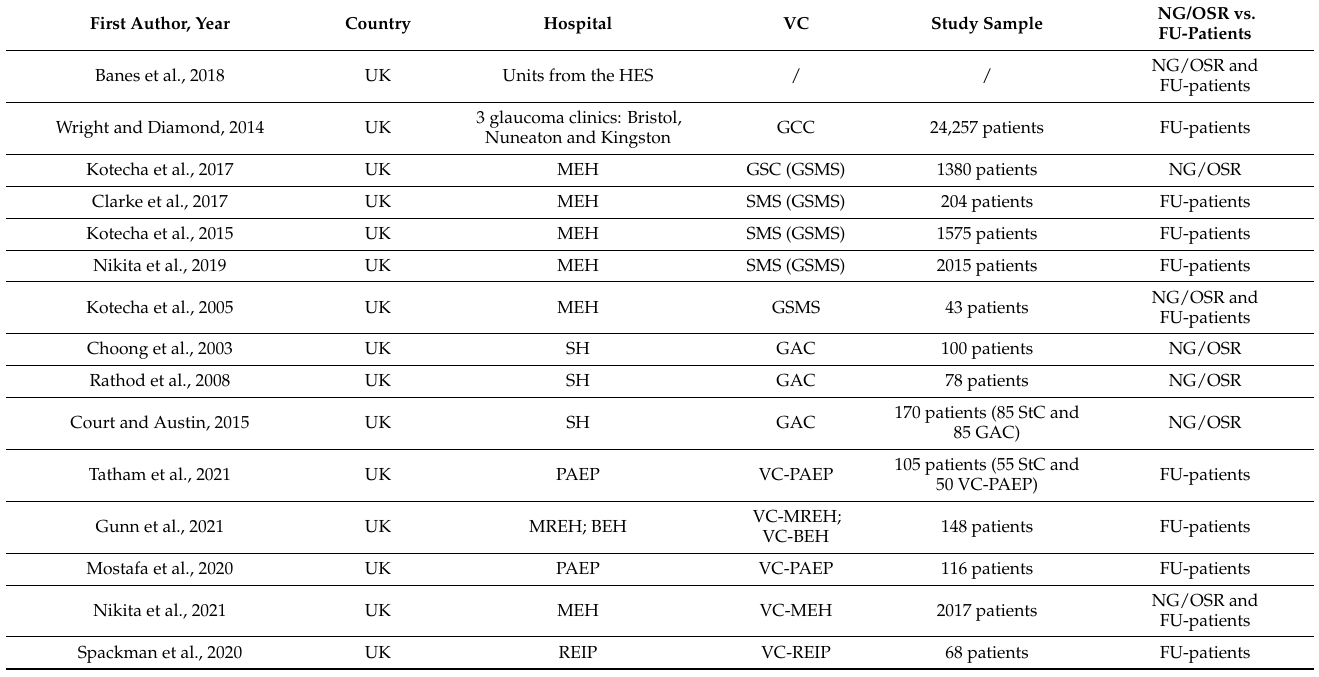
Figure 2. Study selection PRISMA flow chart on Virtual Clinics. Abbreviations: ARVO = Annual Meeting of the Association for Research in Vision and Ophthalmology; n = amount. Table 5. Baseline Characteristics “Virtual